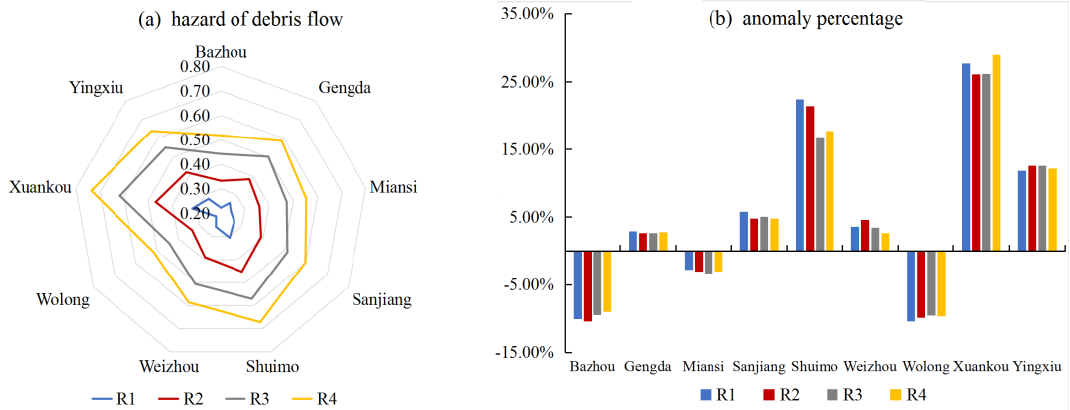
Figure 5. The debris flow risk statistics at the township scale under the four rainstorm scenarios.